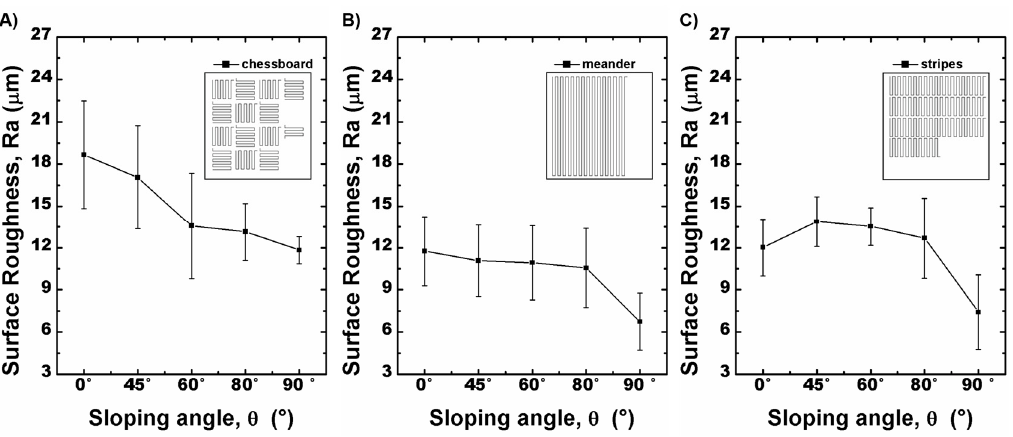
Figure 5. Surface roughness results with different scanning strategies and sloping angles: ( A ) chessboard, ( B ) meander and ( C ) stripes.